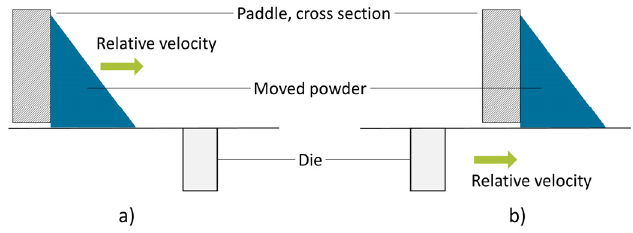
Figure 3. Schematic representation of the two possible states during die filling (PS3): ( a ) paddles overtake dies, ( b ) dies overtake paddles in the filling area. The green arrows represent the relative velocity.